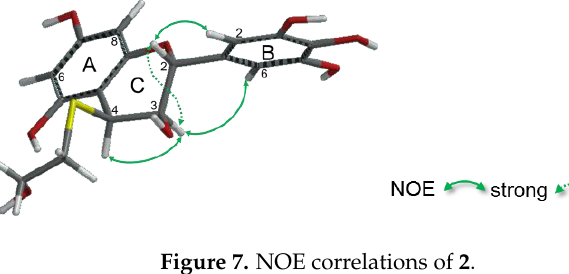
Figure 7. NOE correlations of 2 .